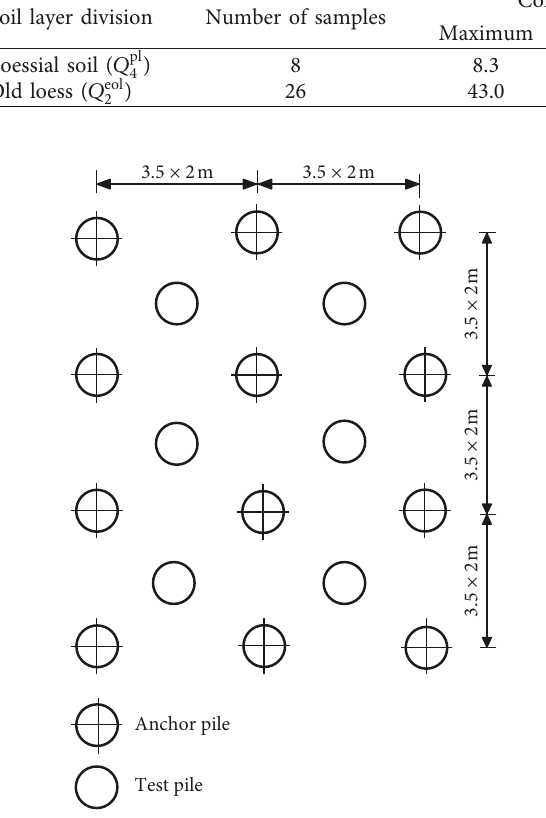
Figure 3: Layout of anchor piles and test piles.